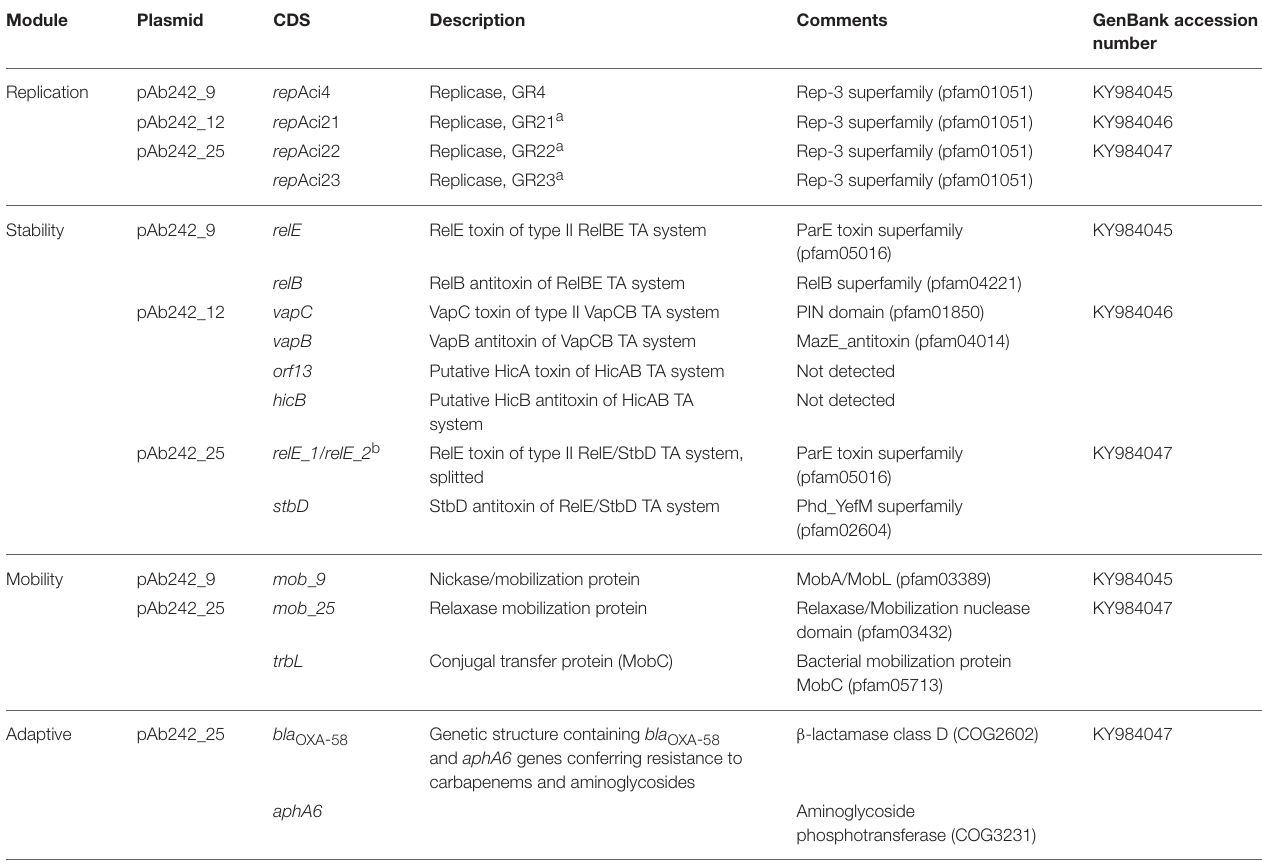
TABLE 1 | Stability, propagation and adaptive modules in Ab242